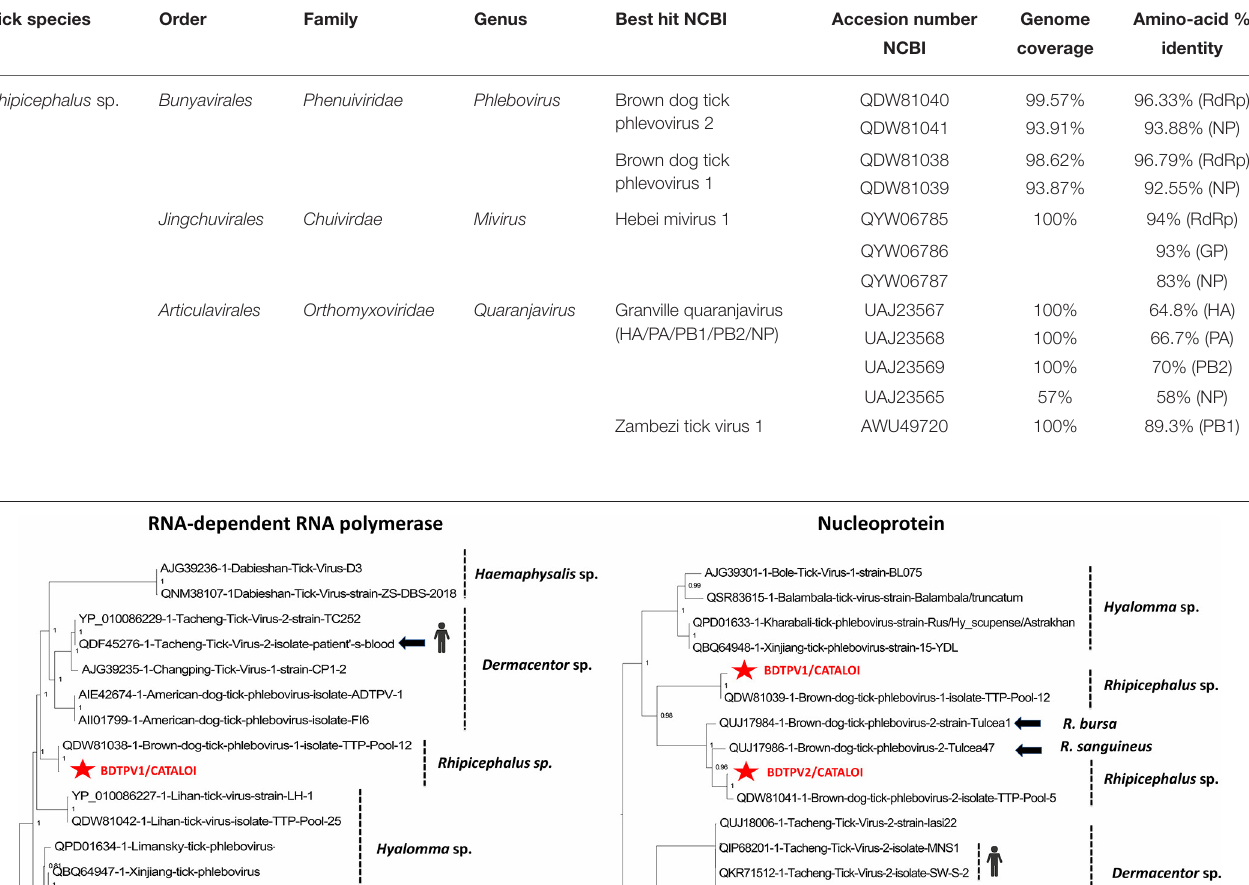
TABLE 1 | Viral sequences identified in ticks from South-Eastern Romania by high-throughput sequencing. Tick species